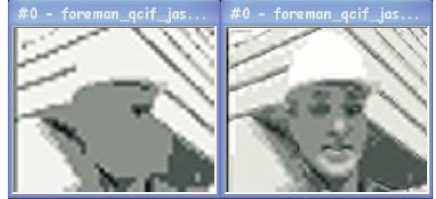
Figure 7: First frame of Foreman QCIF encoded at 70 Kbps (left) and 135Kbps (right).